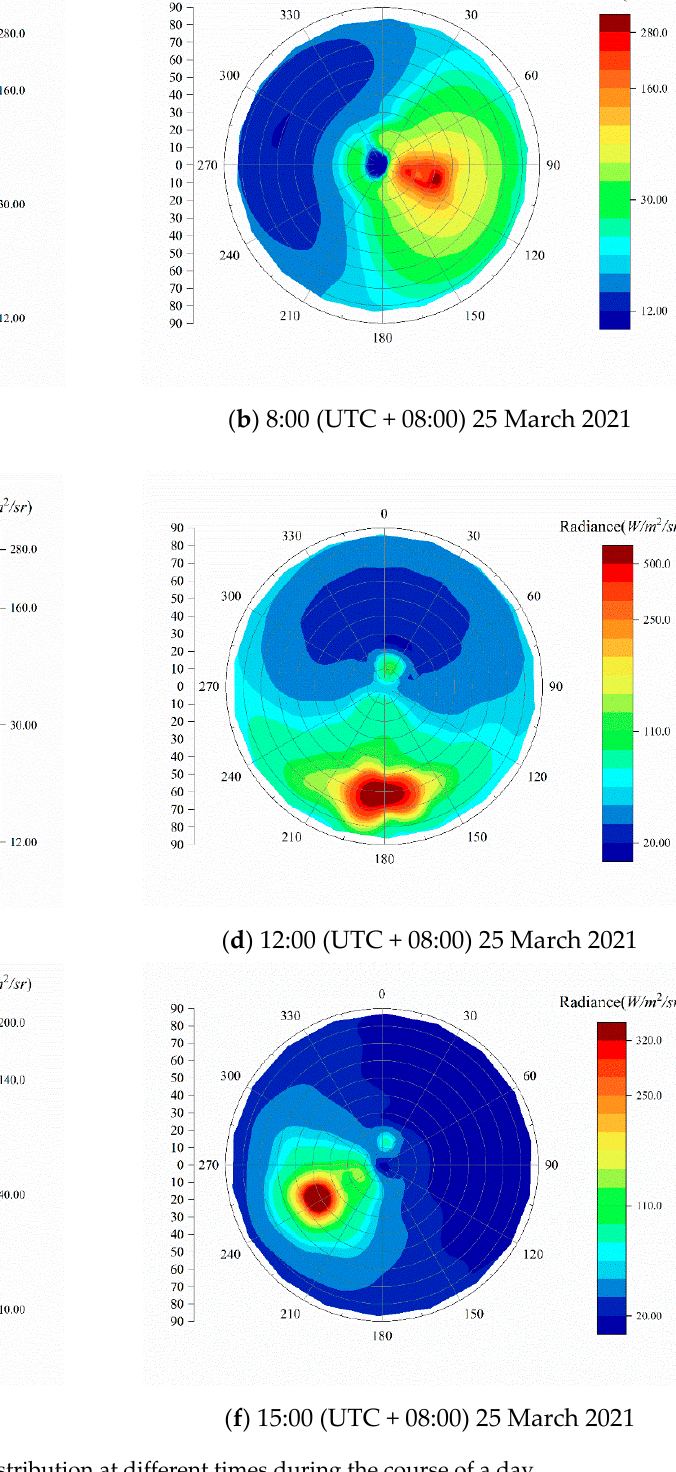
Figure 15. Diffuse-sky radiance distribution at different times during the course of a day.